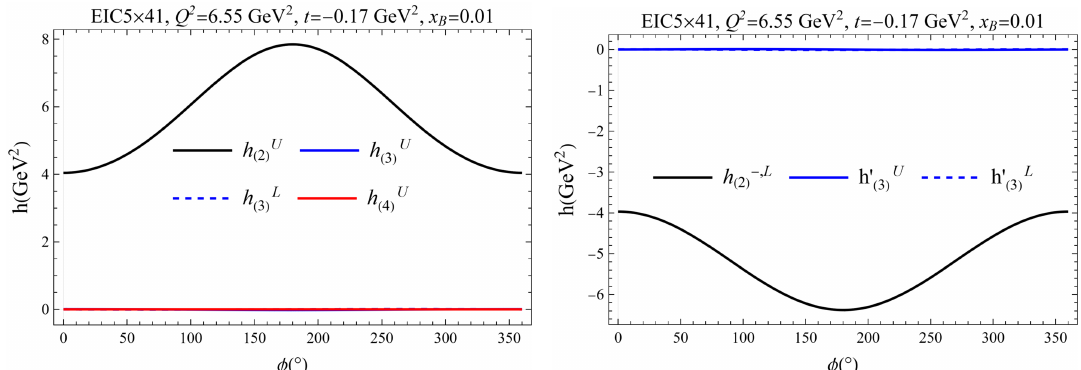
, h U / L and h U , and h − , L and h 0 U / L for EIC5 × 41 (2) (4) (3) (2) (3) and h − , L as the background for comparison. (2) (2)